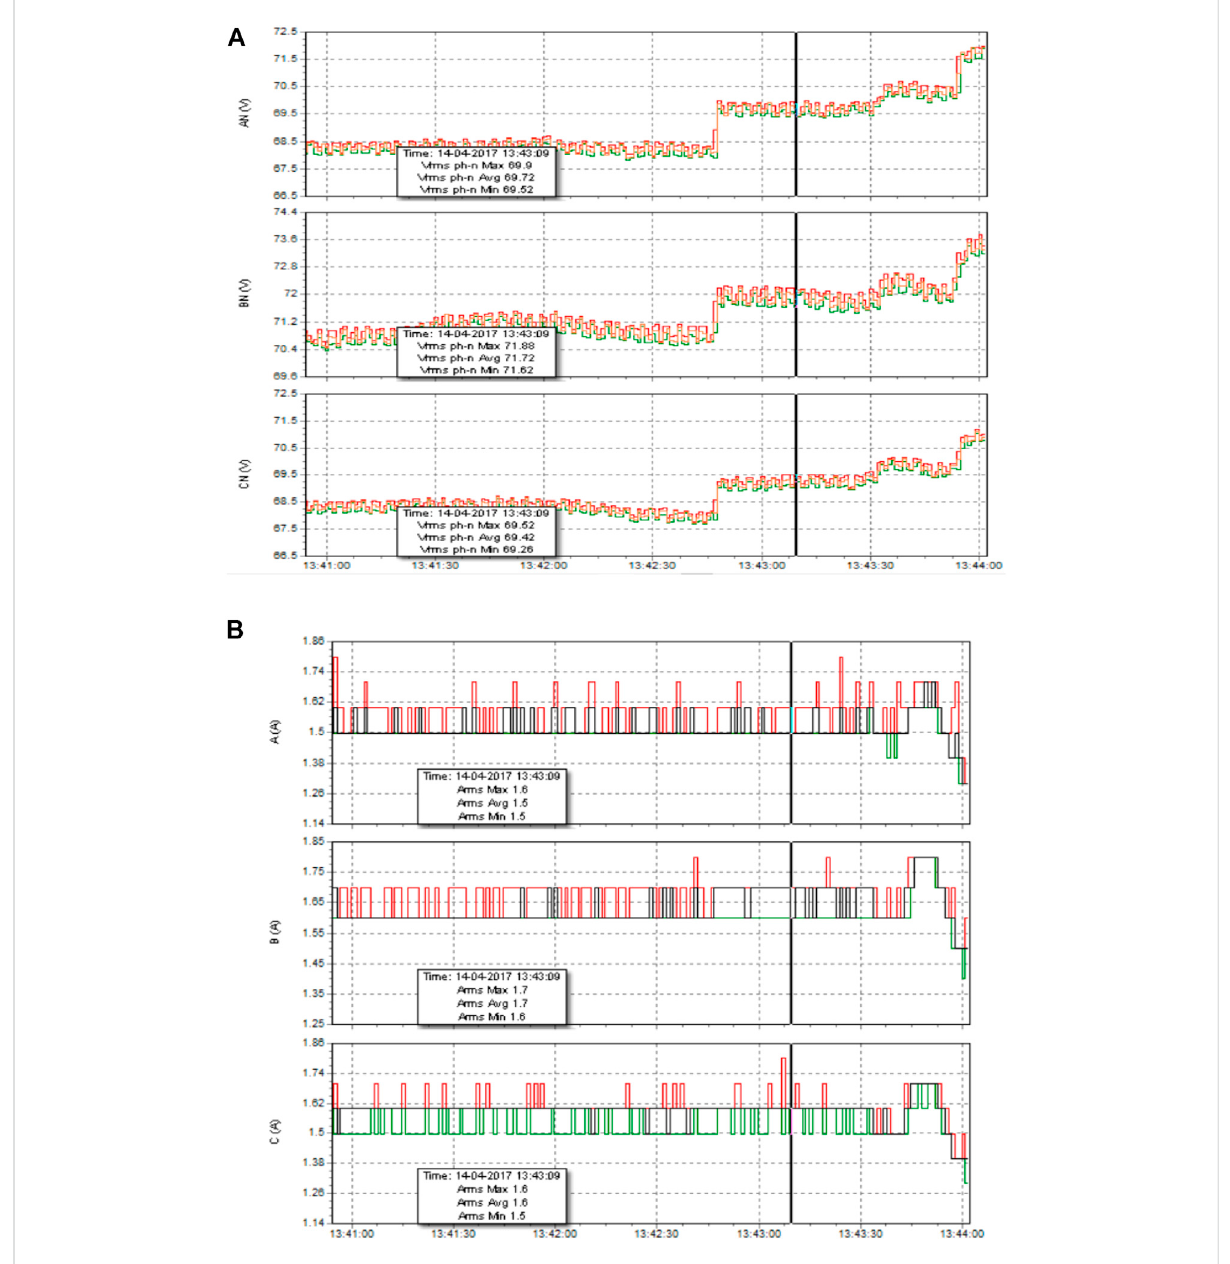
FIGURE 19 3HP, closed-loop unloaded condition 120 V with fi lter kp = 0.1, ki = 0.01 24.7 Ω , 3 mH. (A) Voltage. (B)